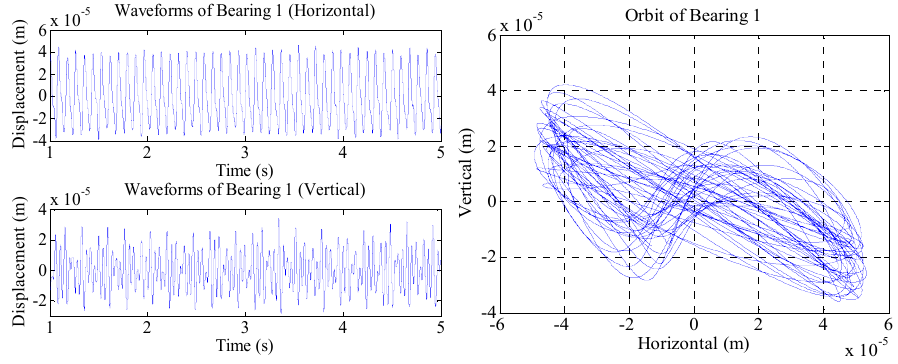
Figure 18. The vibration displacement and orbit of Bearing 1.